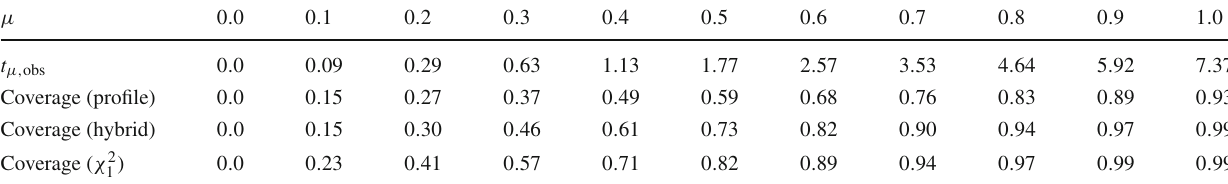
distribution is shown for 1 frequentist-Bayesian treatment of nuisance parameters. The last row shows the asymptotic result obtained with a χ 2 distribution 1